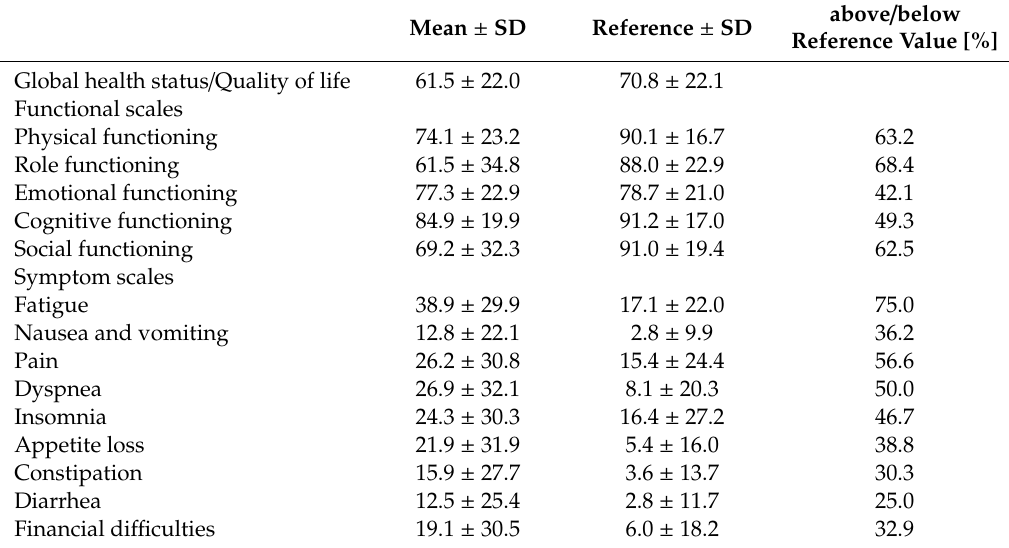
Table 2. Mean scores of the European Organization for Research and Treatment of Cancer Quality of Life Questionnaire Core 30 (EORTC QLQ-C30) and comparison to reference values from the general German population [43]